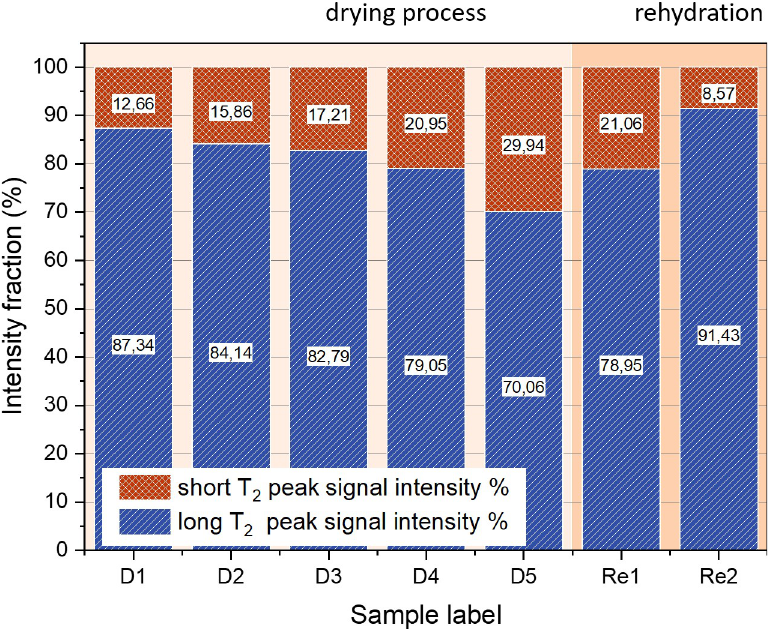
Fig 3. Relationship between the intensities of the two peaks identified in the 1 H T 1 -T 2 maps, as the sample is dried and rehydrated.